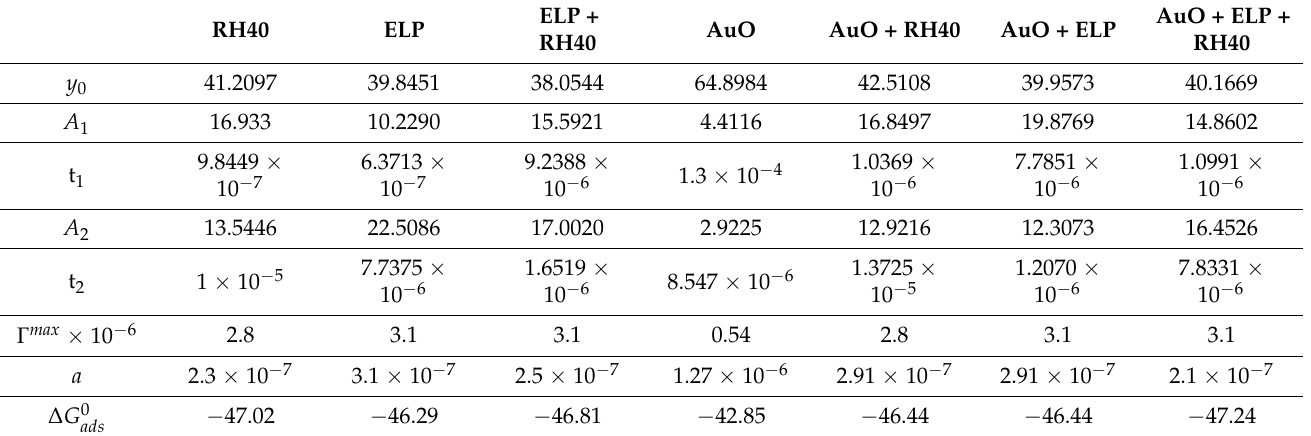
Table 1. The values of the y 0 , A 1 , A 2 , t 1 , t 2 (Equation (5)), Γ max (mol/m 2 , Equation (6)), a (Equation (6)) and ∆ G 0 (kJ/mol, Equation (24)) for AuO, ELP and RH40 as well as AuO + ELP, AuO + RH40 and ads AuO + ELP + RH40